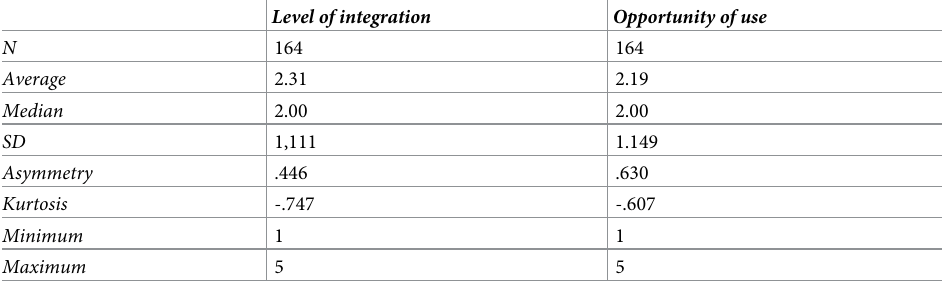
Table 3. Descriptive results regarding level of integration and its use in university classrooms.